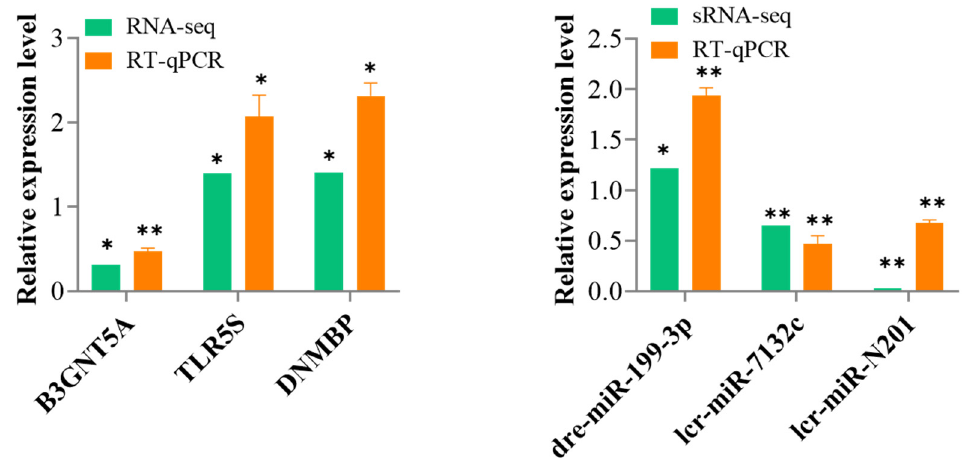
Figure 7. Validation of the small RNA- and RNA-seq results. RT-qPCR verification of the differential expression patterns of randomly selected DEmiRNAs and DEmRNAs at 12 h post-injection ( B3GNT5A, TLR5S , dre-miR-199-3p, and lcr-miR-7132c) and at 24 h post-injection ( DNMBP and lcr-miR-N201). Relative mRNA and miRNA expression levels were calculated with the 2 −ΔΔ Ct method, using β -actin and U6 , respectively, as internal references. Error bars represent the SEM of three independent assays. * p < 0.05; ** p < 0.01; ns, not significant.